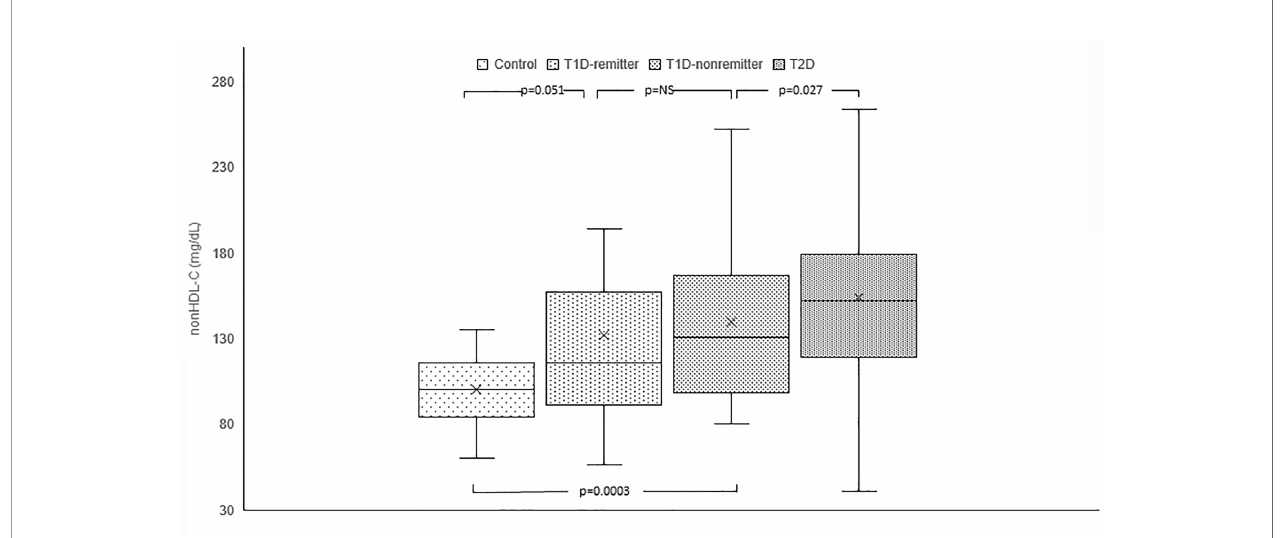
FIGURE 1 | Box plots of early post-diagnostic patterns of non-high density lipoprotein cholesterol (non-HDL-C) in the remitters, non-remitters, and subjects with type 2 diabetes (T2D) compared to controls. The box represents the 50th percent interquartile range, while the ‘ x ’ represents the mean and the horizontal line within the box represents the median, and the upper and lower whiskers represent 25 th percentile above and below the mean, respectively.